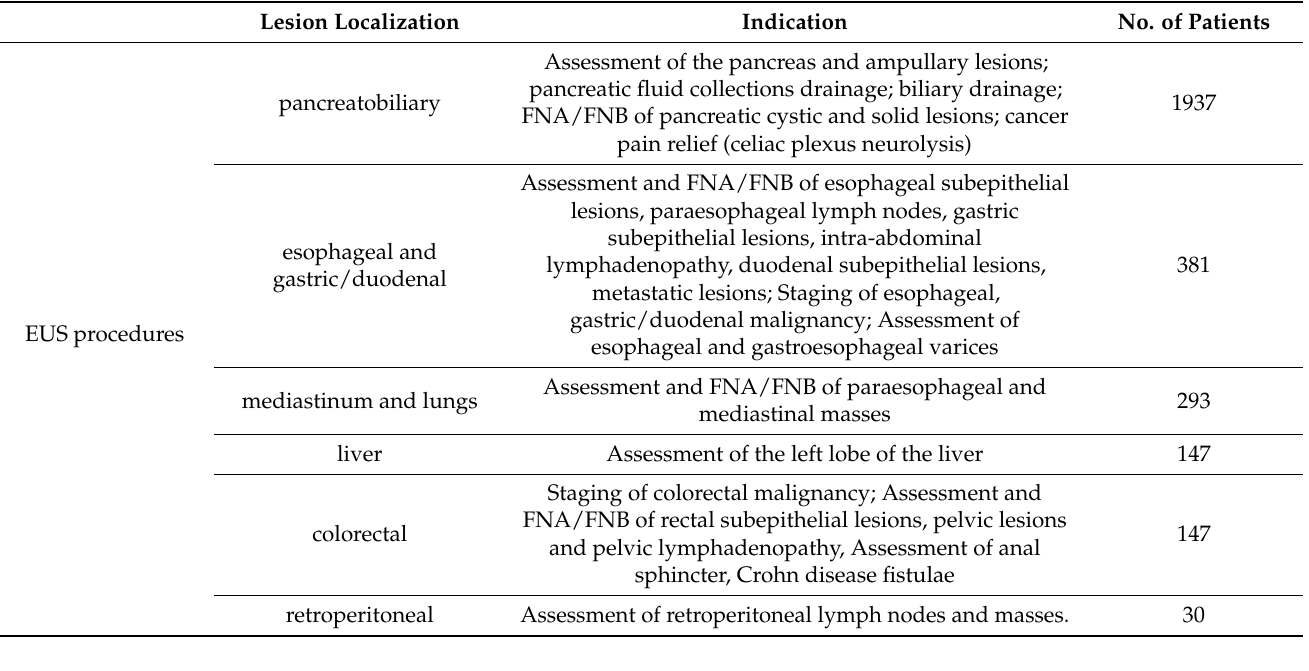
Figure 2. EUS assessment (%) with regard to lesion location. Table 2. Location and indication of EUS procedures.